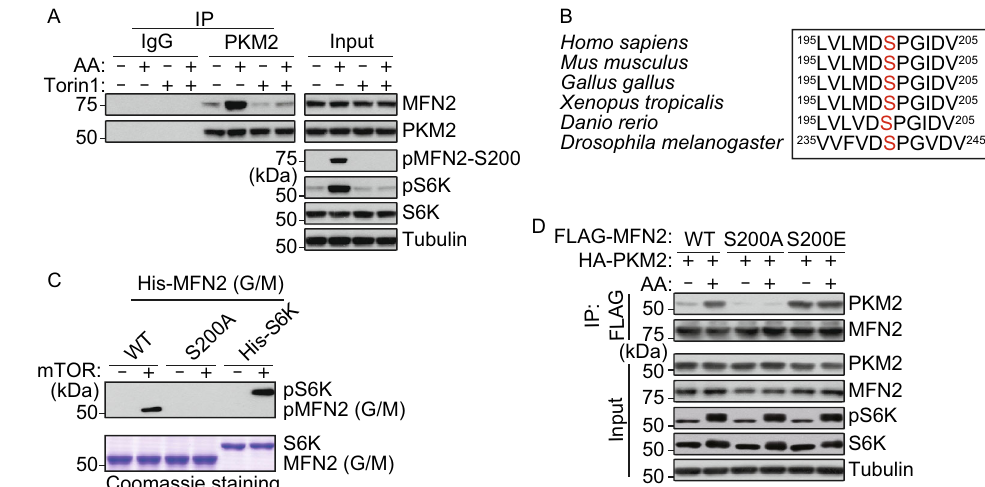
Figure 4. mTOR phosphorylates MFN2 and enhances its binding to PKM2. (A) Co-IP showing the interaction of endogenous PKM2 and MFN2 in H1299 cells in response to treatment with amino acids and/or Torin1. H1299 cells incubated with amino acid-free RPMI1640 for 6 h were exposed to 250 nmol/LTorin1 or control vehicle for another 2 h, and then treated with amino acids for 30 min. (B) Amino acid sequence alignment of MFN2 orthologs. The conserved serine residue (S, red) is phosphorylated by mTOR. (C) In vitro kinase assay showing phosphorylation of the His-tagged G/M fragment of MFN2 (which contains amino acids 97 – 610 of MFN2) and S6K by truncated mTOR. (D) Immunoblots of co-IP assays showing the relative association of PKM2 with WT MFN2 or MFN2 with a Ser-to-Ala or Ser-to-Glu mutation at position 200 (S200A or S200E) in transfected HEK293Tcells in the presence or absence of amino